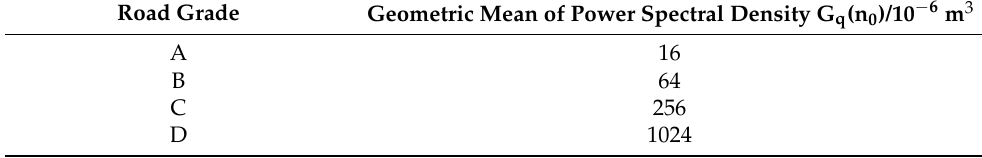
Table 1. Parameters for each grade of pavement.